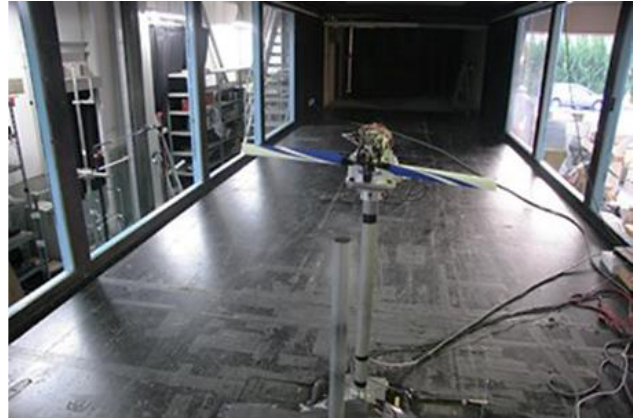
Figure 4. Test model and dummy tower installed in the wind tunnel.